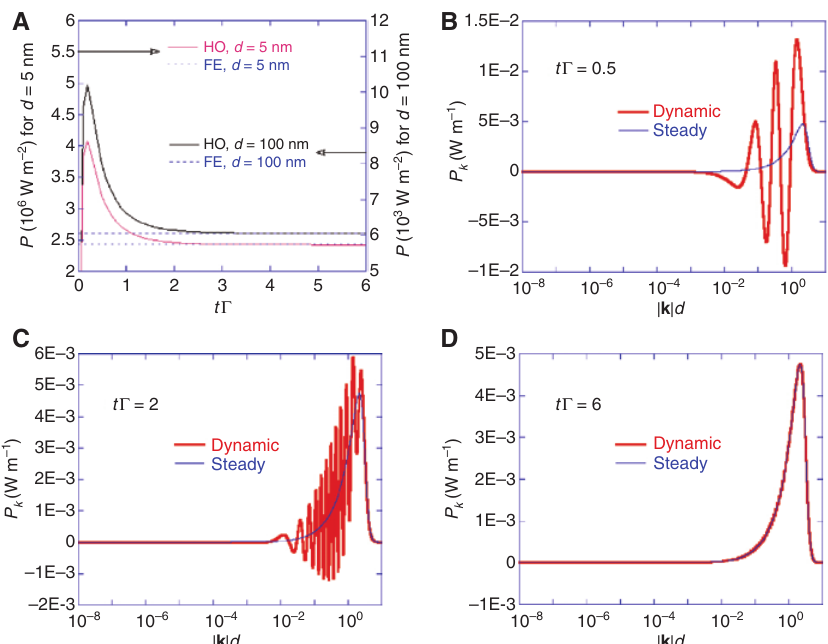
Figure 2: A comparison of the results of dynamical calculation with those of the steady state calculated from fluctuational electrodynamics. (A) Plot of heat flux at room temperature from Eq. (15) (indicated as “HO”) as a function of nondimensional time t Γ between two SiC half- spaces for gaps d = 5 and 100 nm. The calculation of steady-state heat flux from fluctuational electrodynamics principles (indicated as “FE”) from Eq. (19) is also shown. (B–D) Contribution of heat flux as a function of the wavevector component | k | (W m −1 ) for time instants t Γ = 0.5, 2, and 6, respectively, for gap d = 5 nm and compared with the wavevector contribution to the steady-state heat